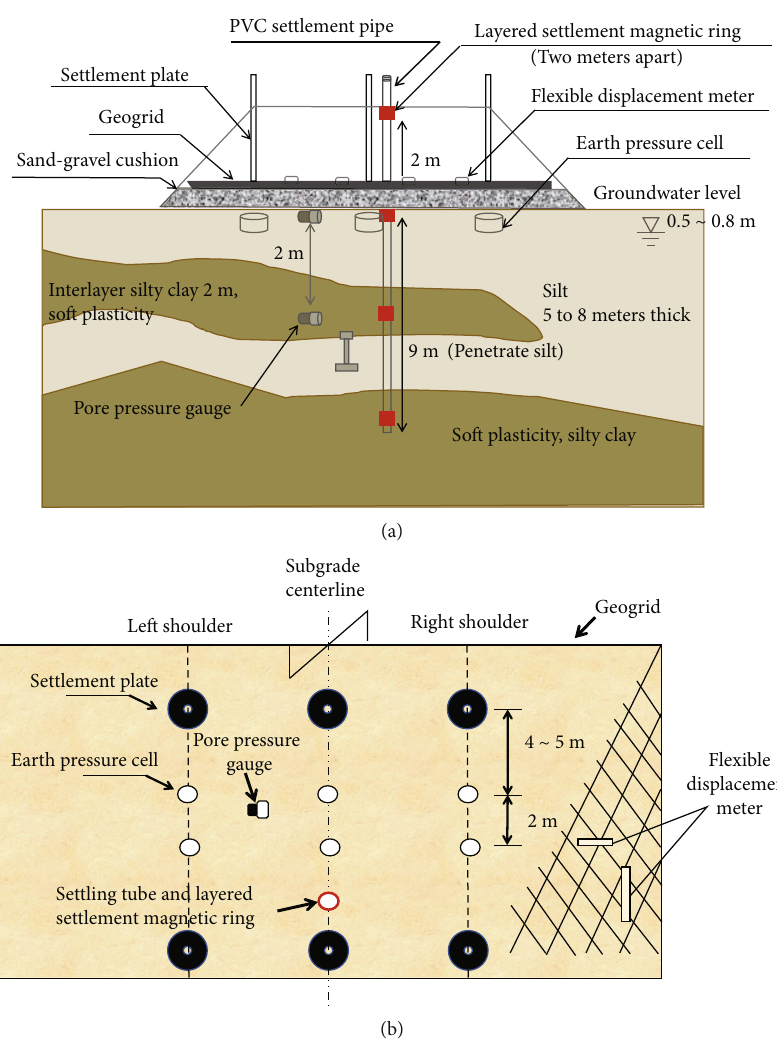
Figure 3: Layout scheme of sensors: (a) layout of the subgrade section and (b) layout of the subgrade